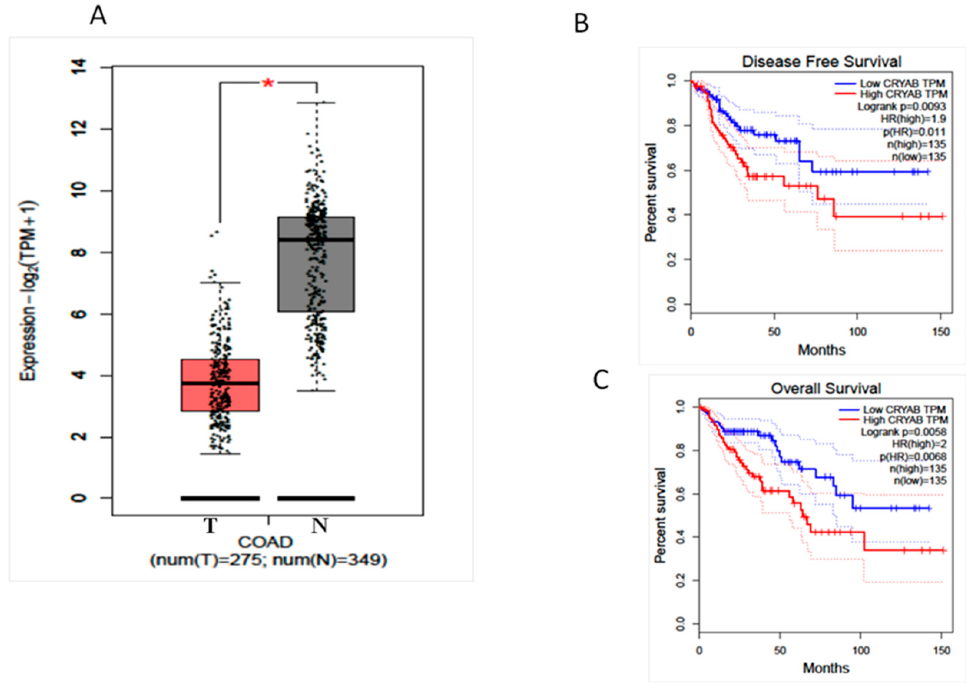
Figure 3. ( A ) CRYAB gene expression comparison between groups: COAD-TCGA, adjacent non-tumoral tissue. CRC: colorectal cancer; COAD: colon adenocarcinoma. Median is represented as a solid black line, whereas mean is represented as a black square. p -value cutoff: 0.01. ( B ) Disease-free survival (DFS) datasets of TCGA of ( C ) overall survival (OS) and datasets of TCGA.